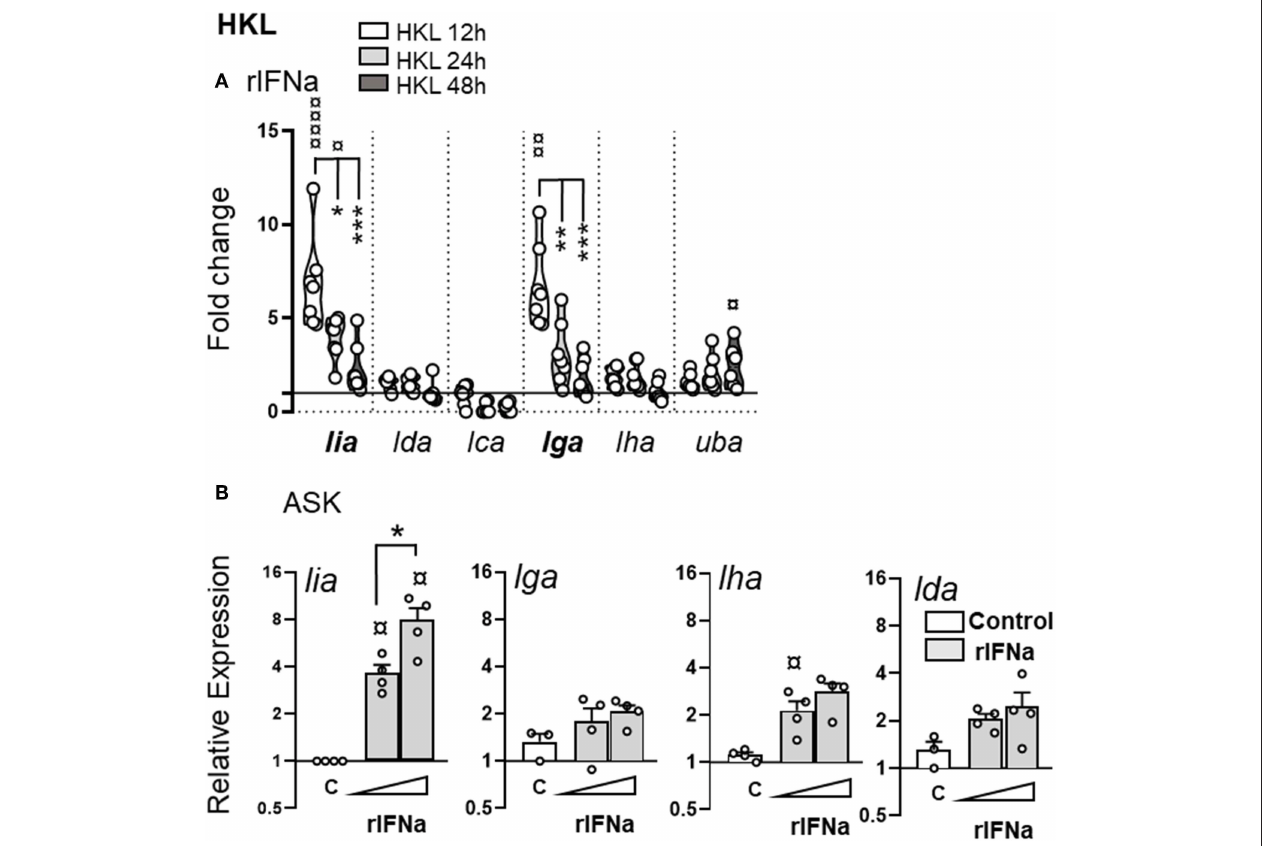
FIGURE 9 | Stimulation with rIFNa upregulates lia and lga transcription. (A) Expression of MHC class I L lineage ( lia, lda, lca, lga, lha, and lfa ) in HKL 12h (white), 24h (light gray), and 48h (dark gray) post stimulation with 500U recombinant (r)IFNa. Gene expression data at each time point were normalized against the reference gene EF1 α B and fold changes were calculated using control cells stimulated with media alone at the same time point. The data represents [n ǫ (6;8)] with each dot representing cells isolated from an individual fish. (B) Relative expression of lia , lga, lha, and lda in ASK cells stimulated with 200U or 500U rIFNa for 24h. C, unstimulated cells. The line intersecting the y-axis at 1 represents the control that the fold change of the treatments is in relation to. Asterisks indicates the strength of significance between the indicated time points and ¤ indicate significant upregulation compared to control stimulated cells: * p < 0.05, ** p < 0.001, *** p < 0.0001.